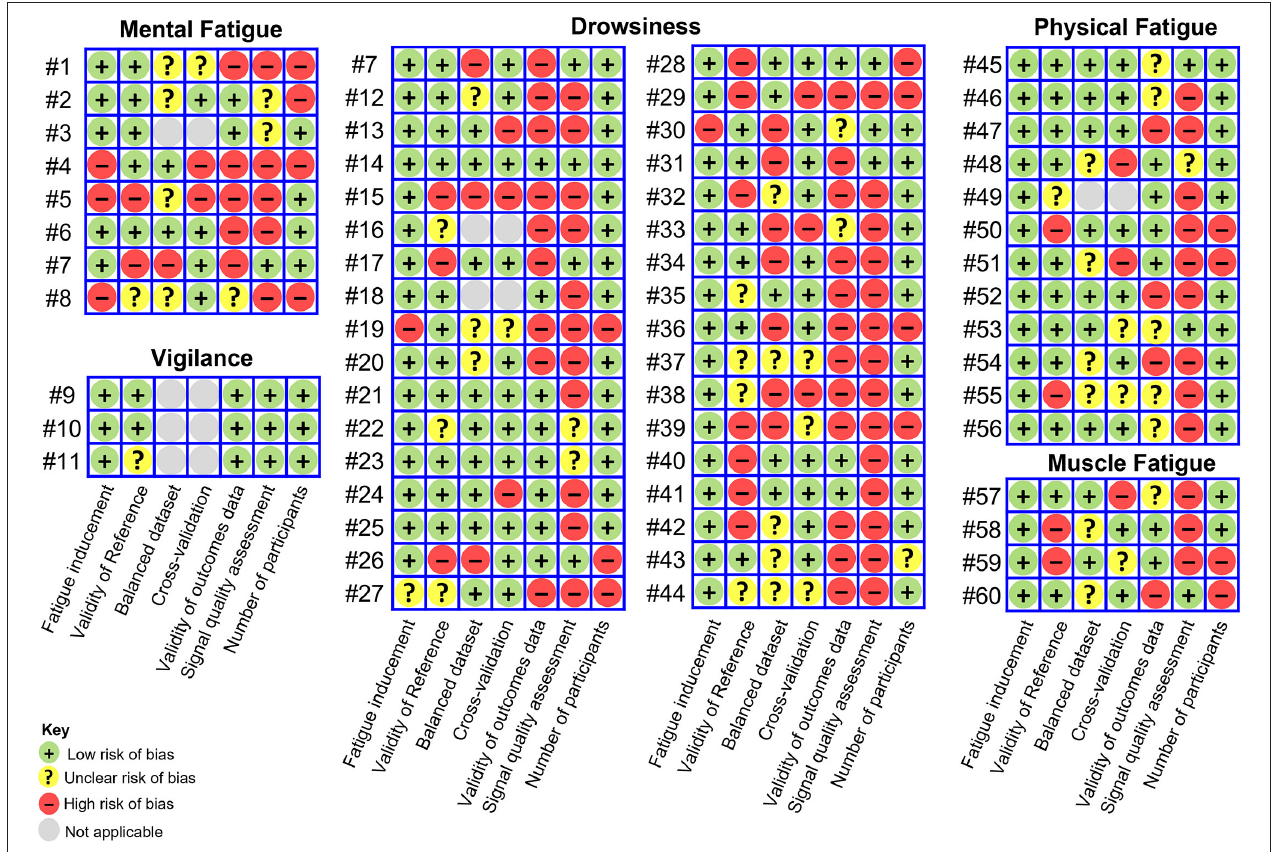
FIGURE 5 | Risk of bias assessment. Studies with low risk of bias in all components were deemed to be of low risk of bias, studies with low or unclear risk of bias for all components were deemed to be of unclear risk and those with high risk of bias for one or more components were deemed to be of high risk of